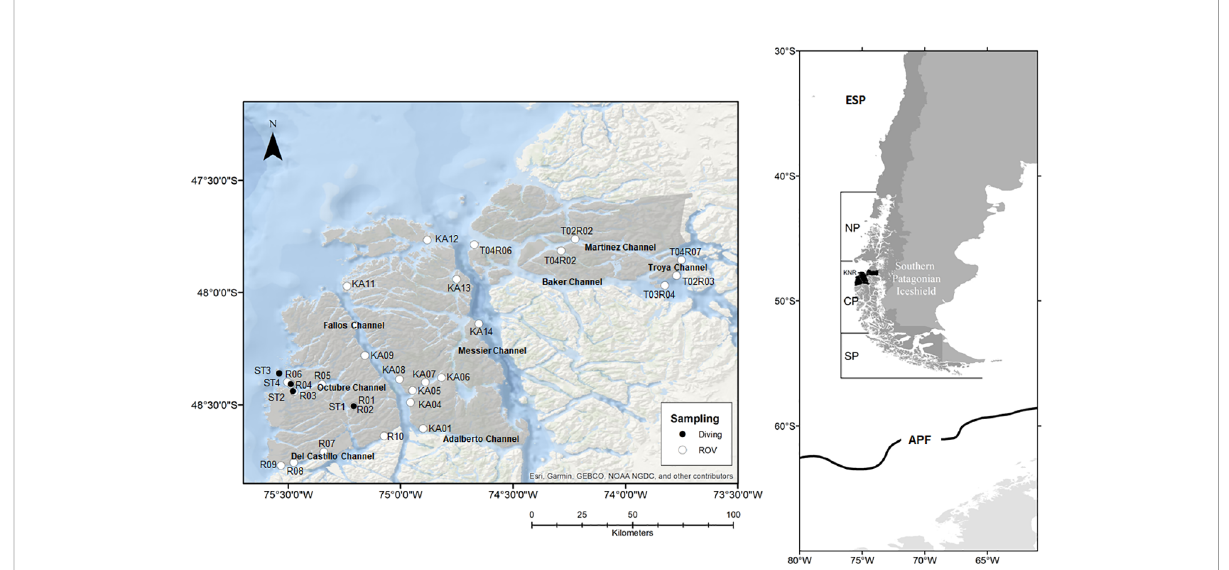
FIGURE 1 Map indicating the positions of the ROV and diving stations across the fjords and channels in the KNR waters. The gray landscape represents the area of the